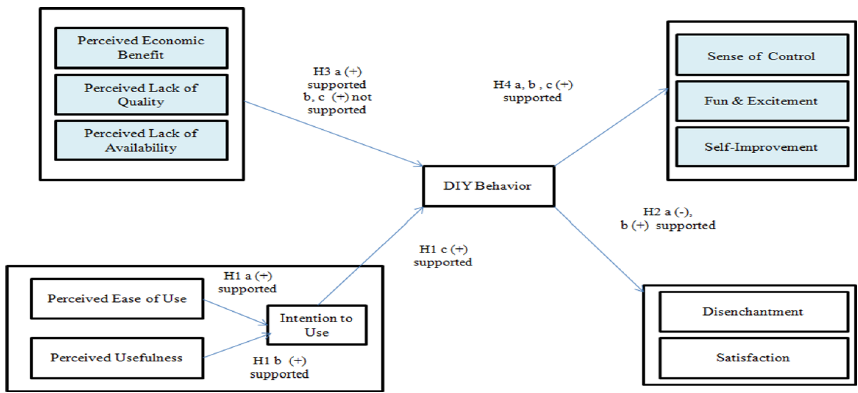
Fig. 1 TAM and DIY digitalization